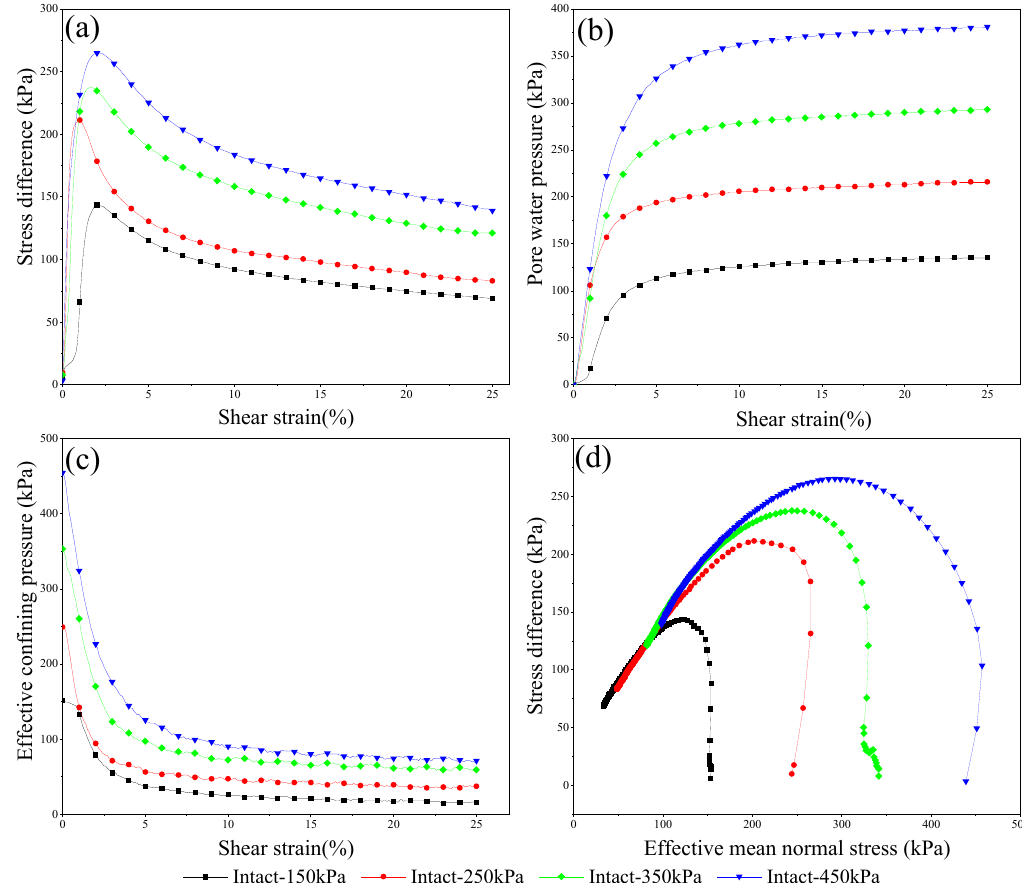
Figure 7. Consolidated undrained triaxial test results for undisturbed saturated loess. ( a ) Stress-strain curve of intact loess, ( b ) pore water pressure curve of intact loess, ( c ) effective confining pressure curve, and ( d ) effective stress paths.